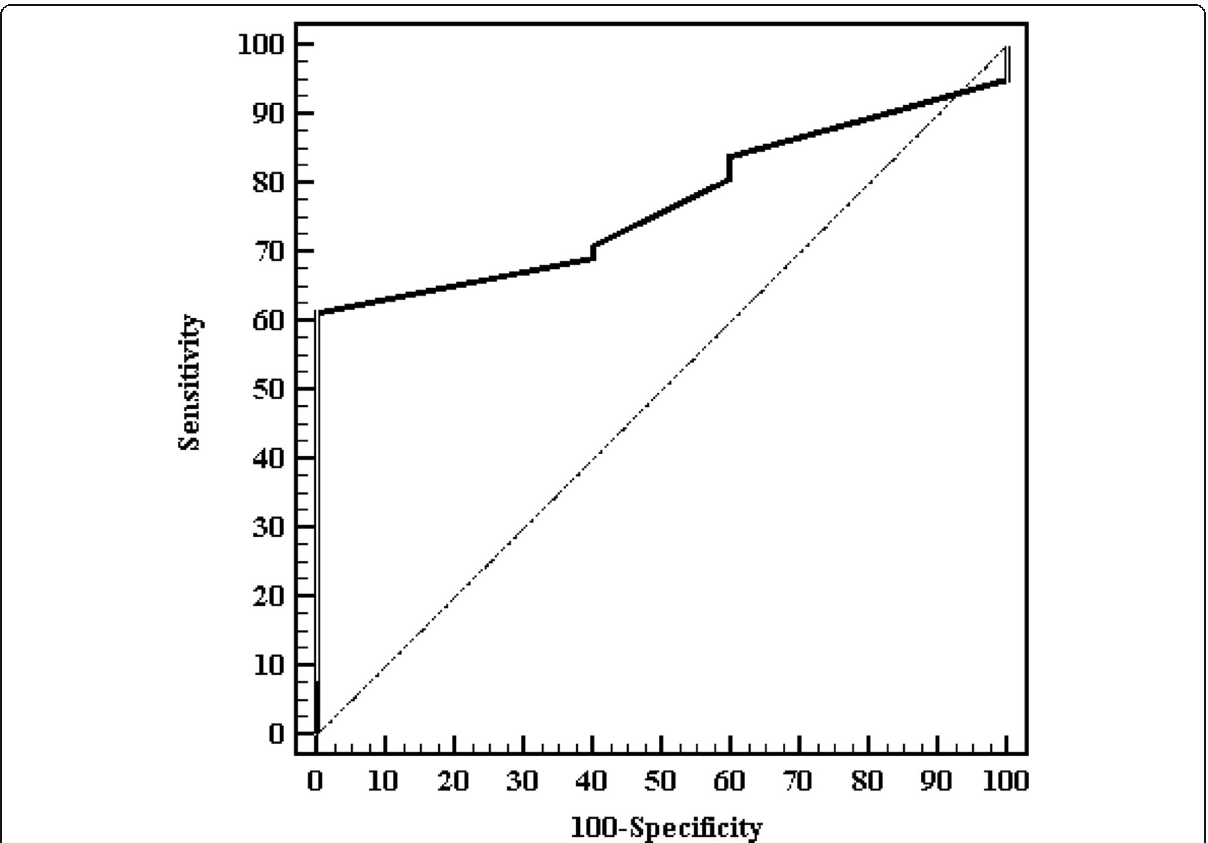
Fig. 1 ROC curve to assess agreement (sensitivity, specificity) of the ADC value to diagnose neoplastic from non – neoplastic lesions. A cutoff value of > 0.85 × 10 − 3 mm 2 /s can be used to differentiate neoplastic from non – neoplastic lesions with a sensitivity of 69.35% and specificity of 60.0%